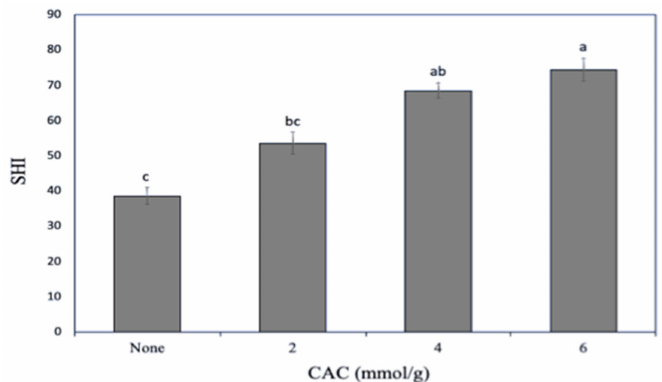
Figure 2. Effect of increasing capric acid chloride (CAC) amounts on the secalin surface hydrophobic- ity index (SHI). The lowercase letters (a–c) indicate significant differences among the values reported in each bar ( p < 0.05). Further experimental details are given in the text.